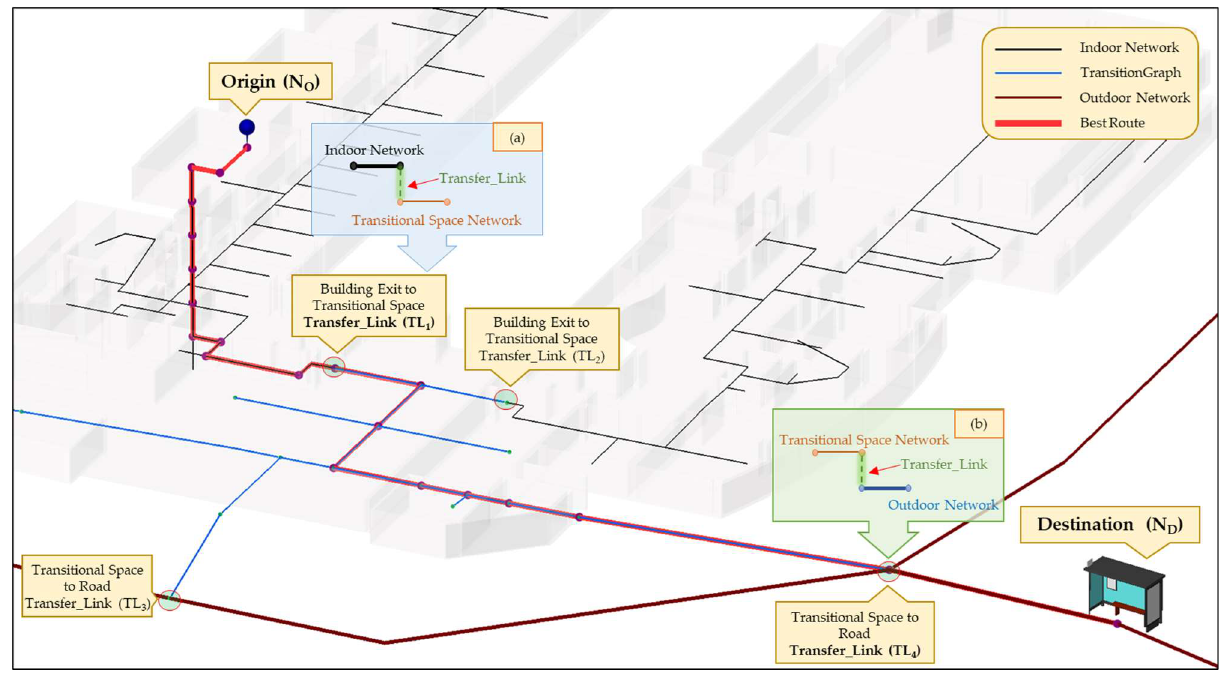
Figure 15. Route analysis for the proposed model.